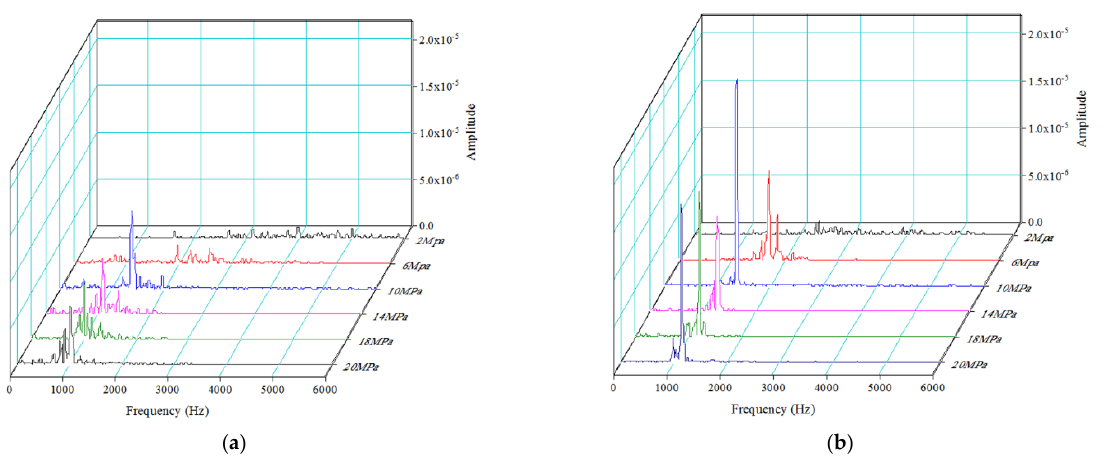
Figure 11. Frequency-domain distribution for mode_1 of the cavitating jet images. ( a ) Cavitating jet by nozzle without whistle. ( b ) Cavitating jet by nozzle with divergent whistle.